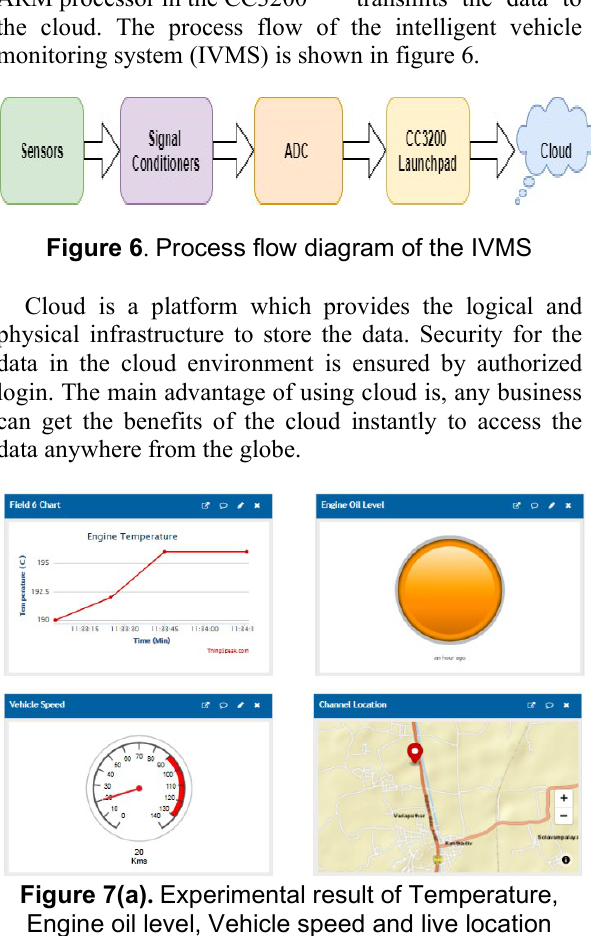
Figure 7(b) . Experimental results of Vehicle load, Fuel level, Theft indication and battery